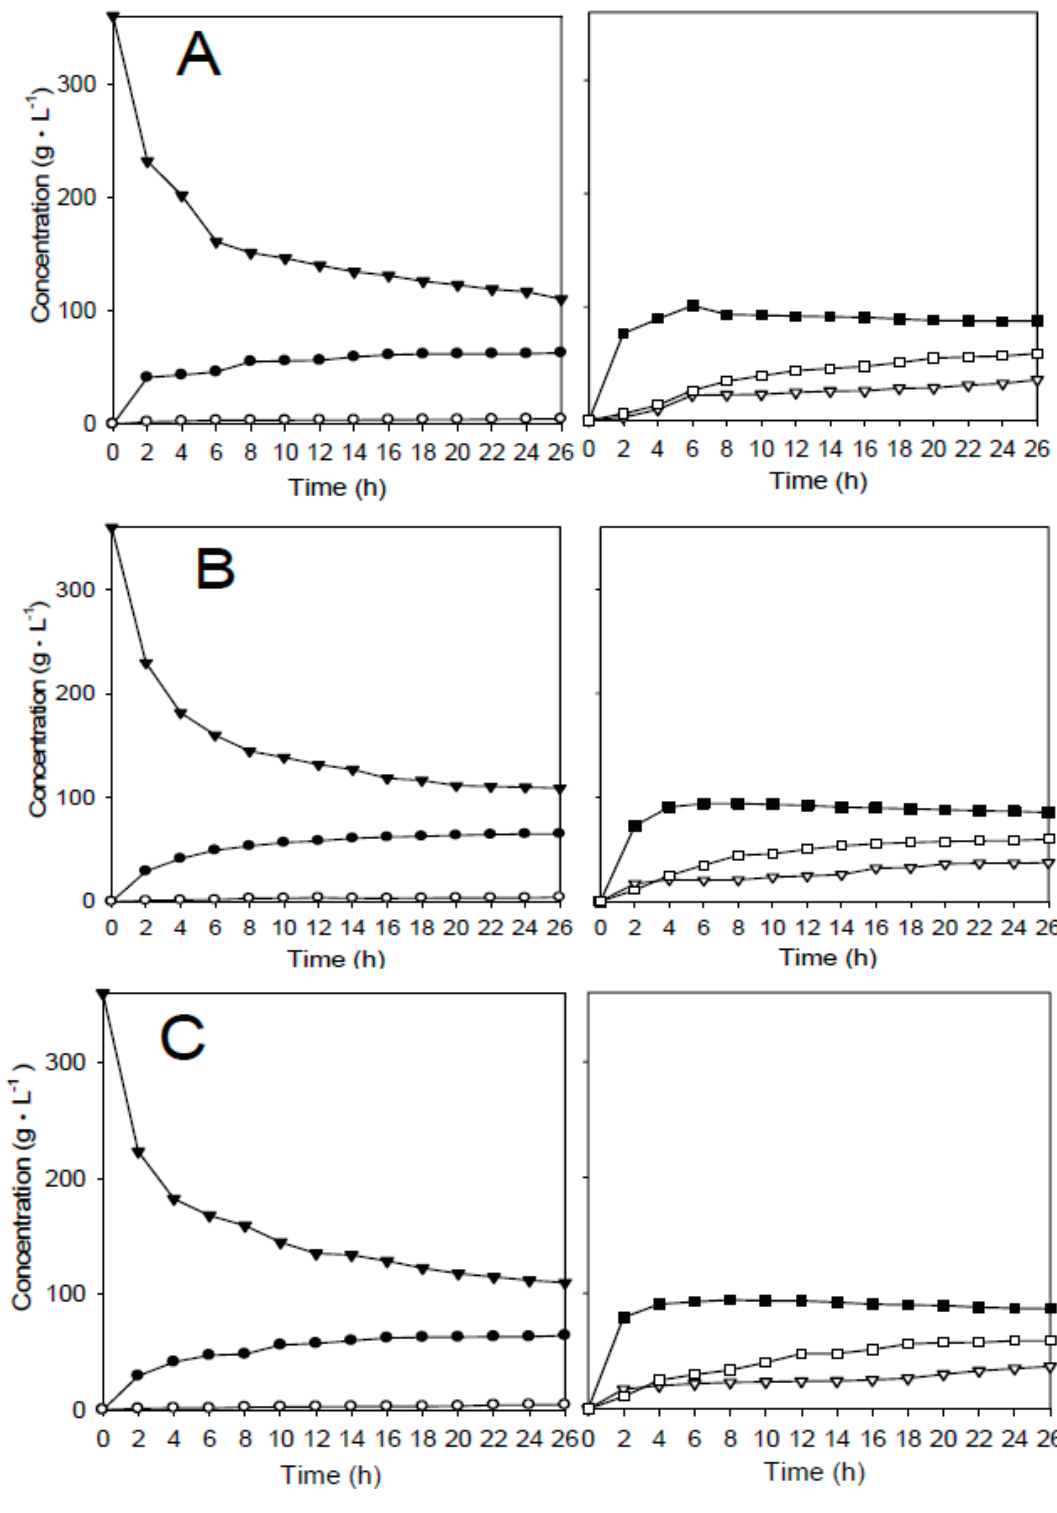
Figure 7. Time-course analysis of various sugars produced. ( A ) free enzyme; ( B ) Fe 3 O 4 -CS-immobilized; and ( C ) Fe 3 O 4 -CS-THP-immobilized enzyme. The reaction was carried out at 45 °C at pH 6.0 with a 36% lactose solution (w·v − 1 ). 3.5 units of enzyme were added per gram of lactose. ( ▼ ) lactose; ( ● ) glucose; ( ○ ) galactose; ( ▽ ) disaccharide; ( ■ ) trisaccharide; ( □ )